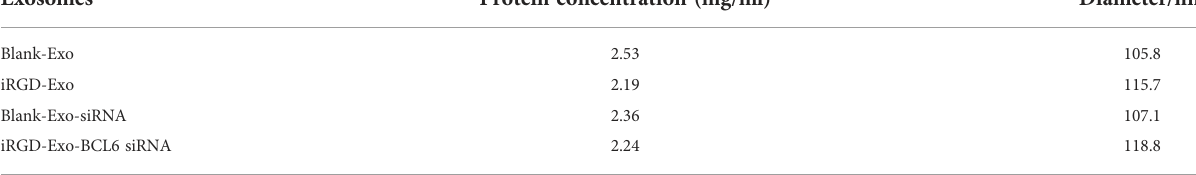
TABLE 1 The protein concentration and diameter of isolated